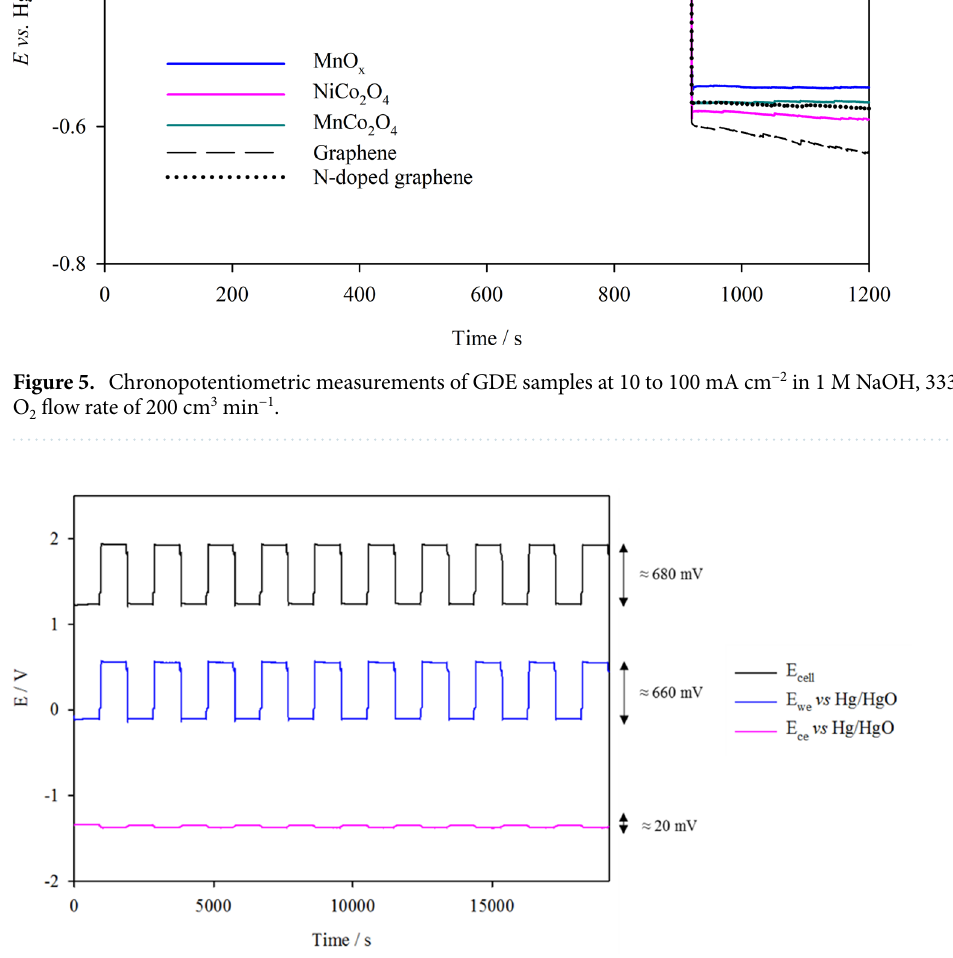
Figure 6. Galvanostatic cycling data at 20 mA cm −2 with 30 min cycle periods and 1 min OCV after each charge/discharge step. Oxygen electrodes MnO x on C paper (ORR) and Ni-Fe-Co(OH) 2 on SS mesh (OER) were positioned on either side of the Zn anode in static 4 M NaOH + 0.3 M ZnO at 333 K and O 2 flow rate of 200 cm 3 min −1